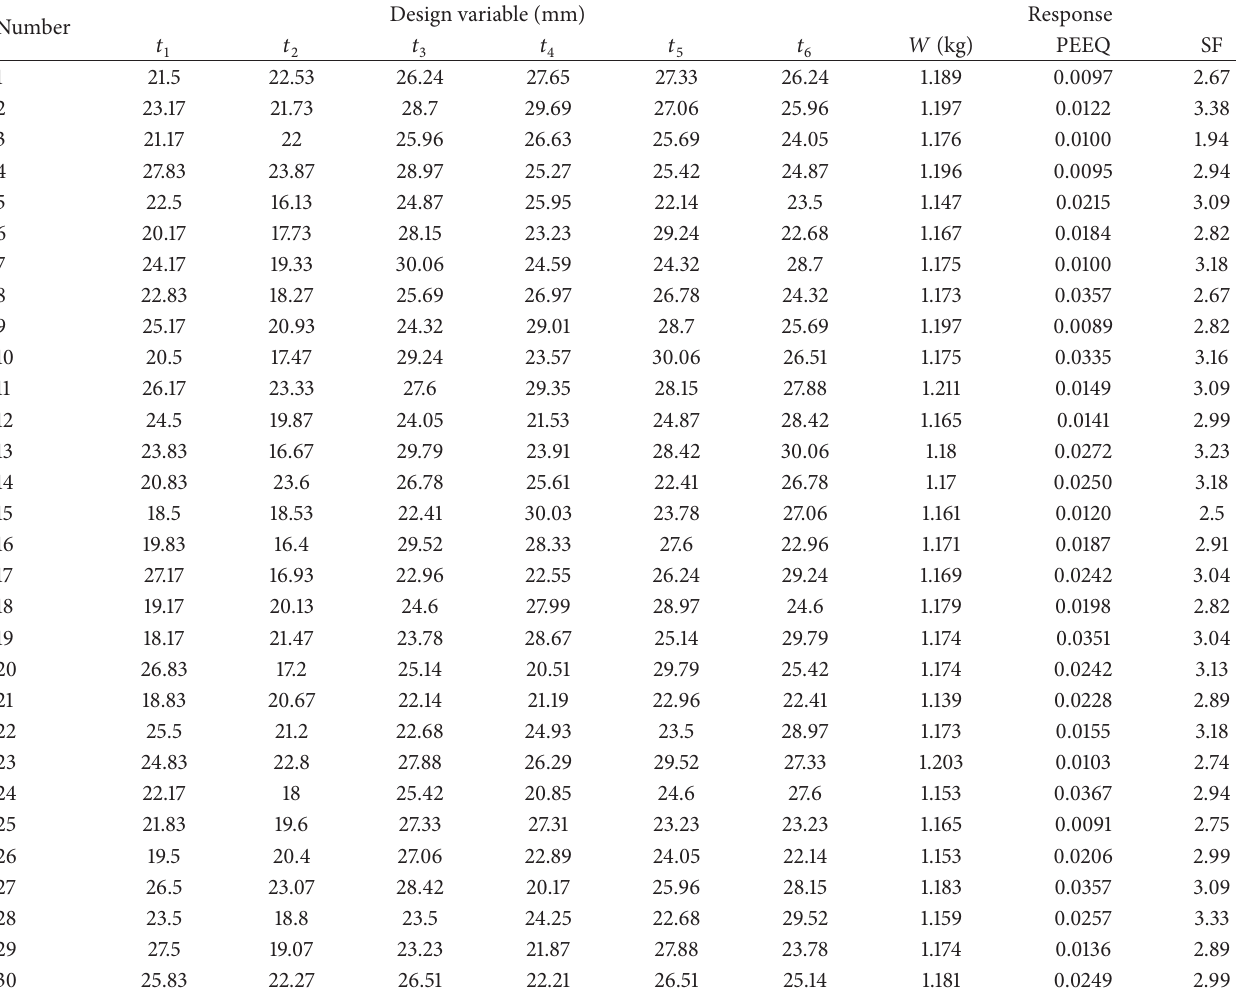
Table 4: Design of experiments using LHD.